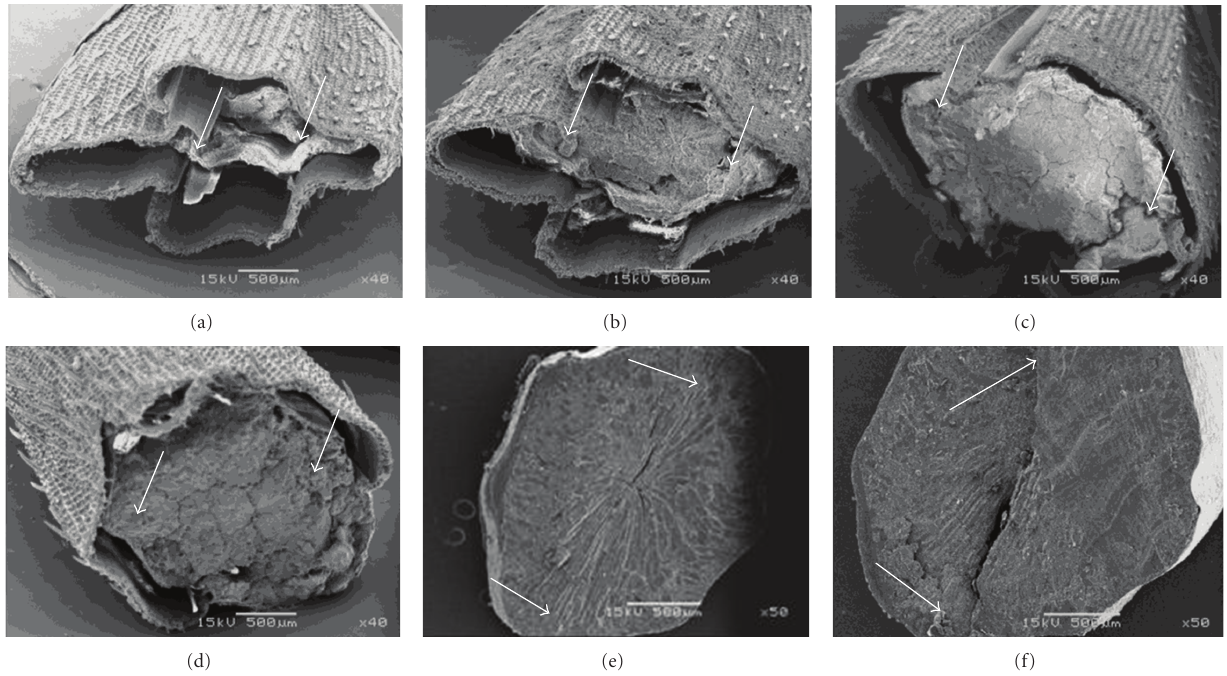
Figure 3: Gallery of SEM photomicrographies (transversal section) showing rice grain development of Morelos A-98: (a) 7 DAF; (b) 14 DAF; (c) 21 DAF; (d) 28 DAF; (e) 35 DAF; (f) polished grain rice. (Images(a)–(d) have a 40X magnification, whereas (e)–(f) have 50X; arrows indicate sampling position according to that established in Section